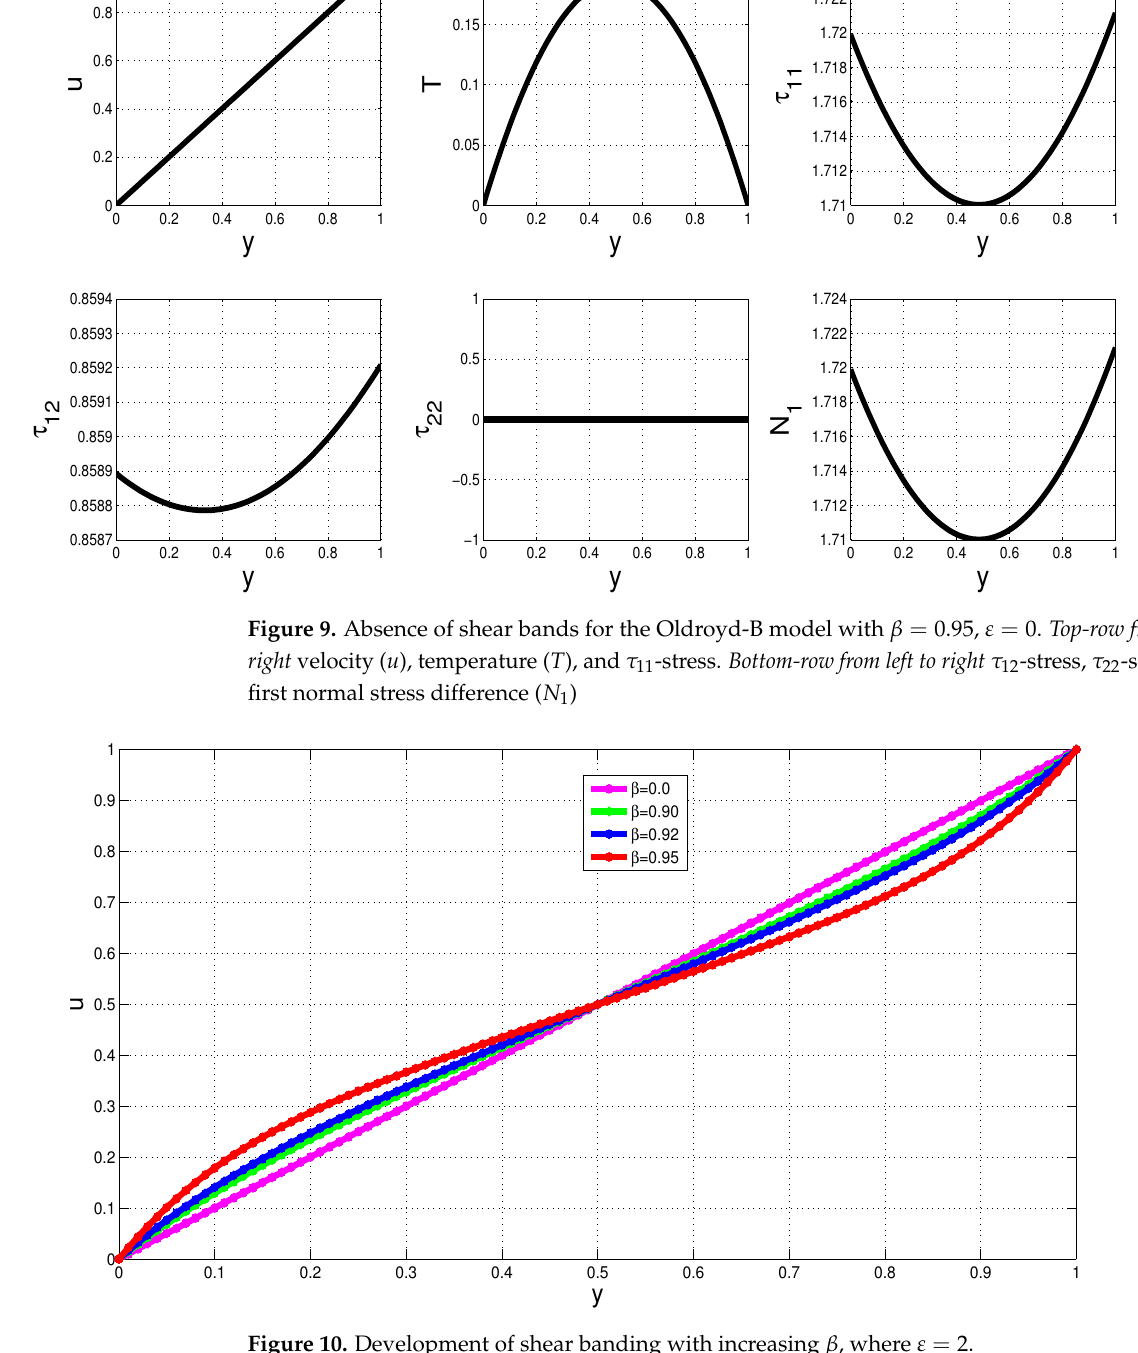
Figure 10. Development of shear banding with increasing β , where ε =